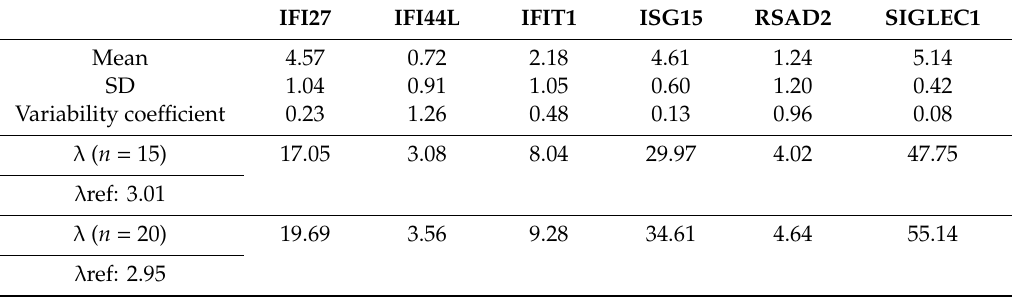
Mean, standard deviation (SD) and variability coefficient values previously determined on ten subjects are reported in the table. λ ref: noncentrality parameter ( λ ) calculated based on α = 0.05, β =